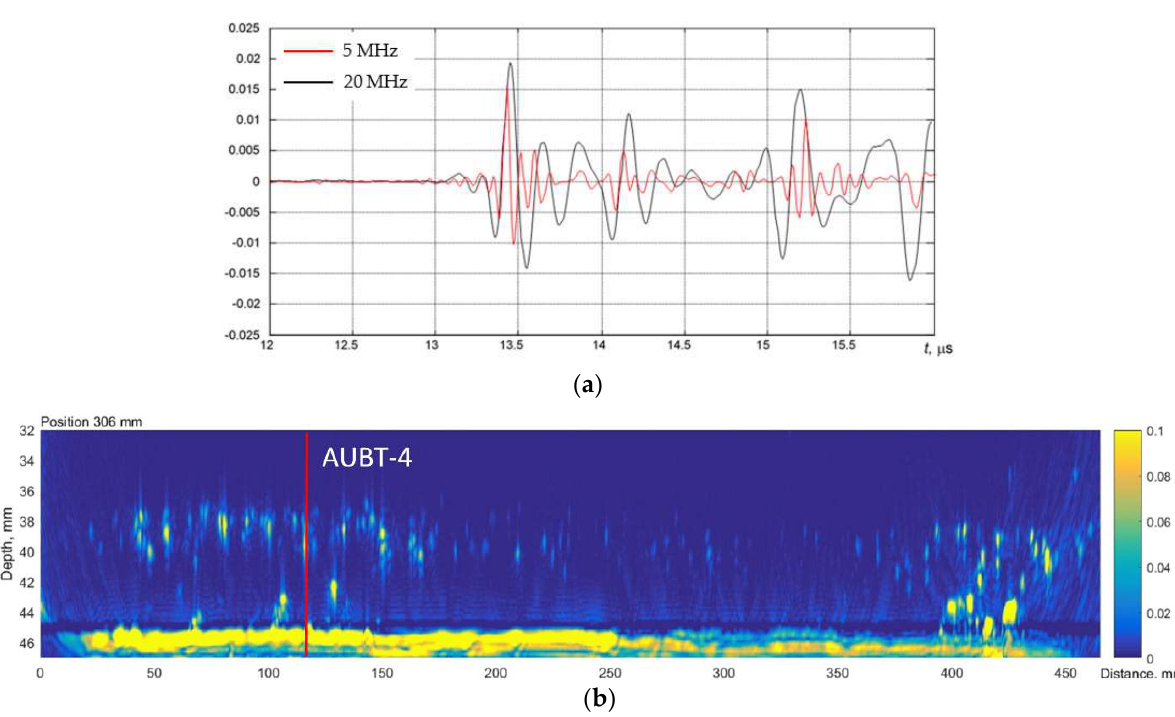
Figure 11. ( a ) The waveforms of the received signals at the point AUBT-4 with 5 MHz (black) and 20 MHz (red) transducers and ( b ) the corresponding TFM image, showing appropriate AUBT measurement location. Vertical colour bar represents the peak-to-peak amplitude in arbitrary units.